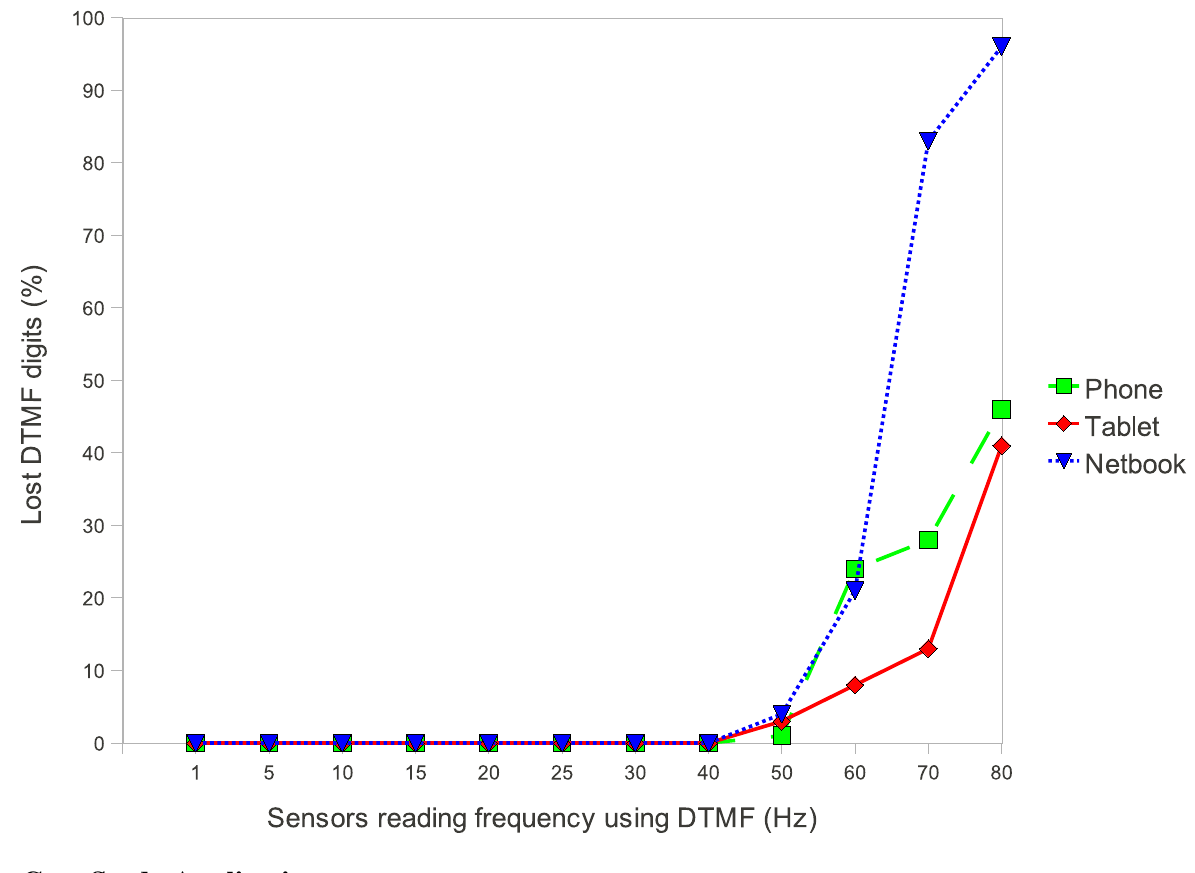
Figure 4. DTMF digit recognition performance in different